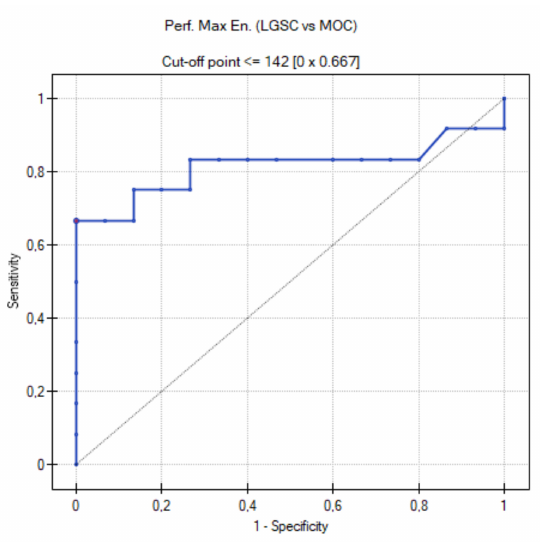
Figure 12. ROC curve for diagnostic performance of the TTP parameter in detection of EOC (LGSC vs. MOC).